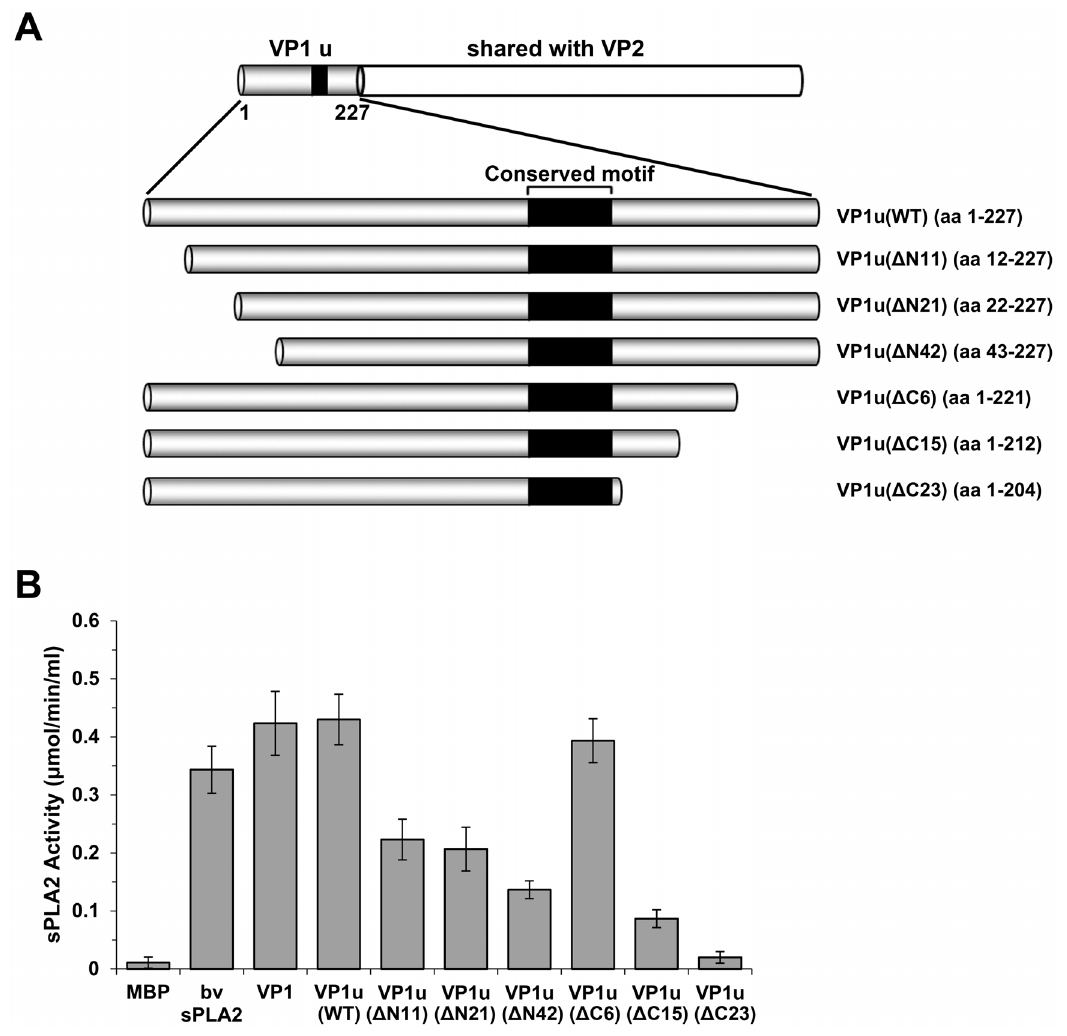
Figure 2. PLA2 activity of different truncated VP1 mutants. (A) Schematic representation of the truncated VP1u region. Six plasmids were constructed to express the C-terminal and N-terminal truncated proteins. The amino acid numbers of the proteins are shown in parentheses. The VP1u region is illustrated at the top. (B) The PLA2 activity of different truncated VP1u proteins. Truncated VP1u proteins, 10 m g of each; bee venom, 10 ng. Data are representative of three independent experiments.